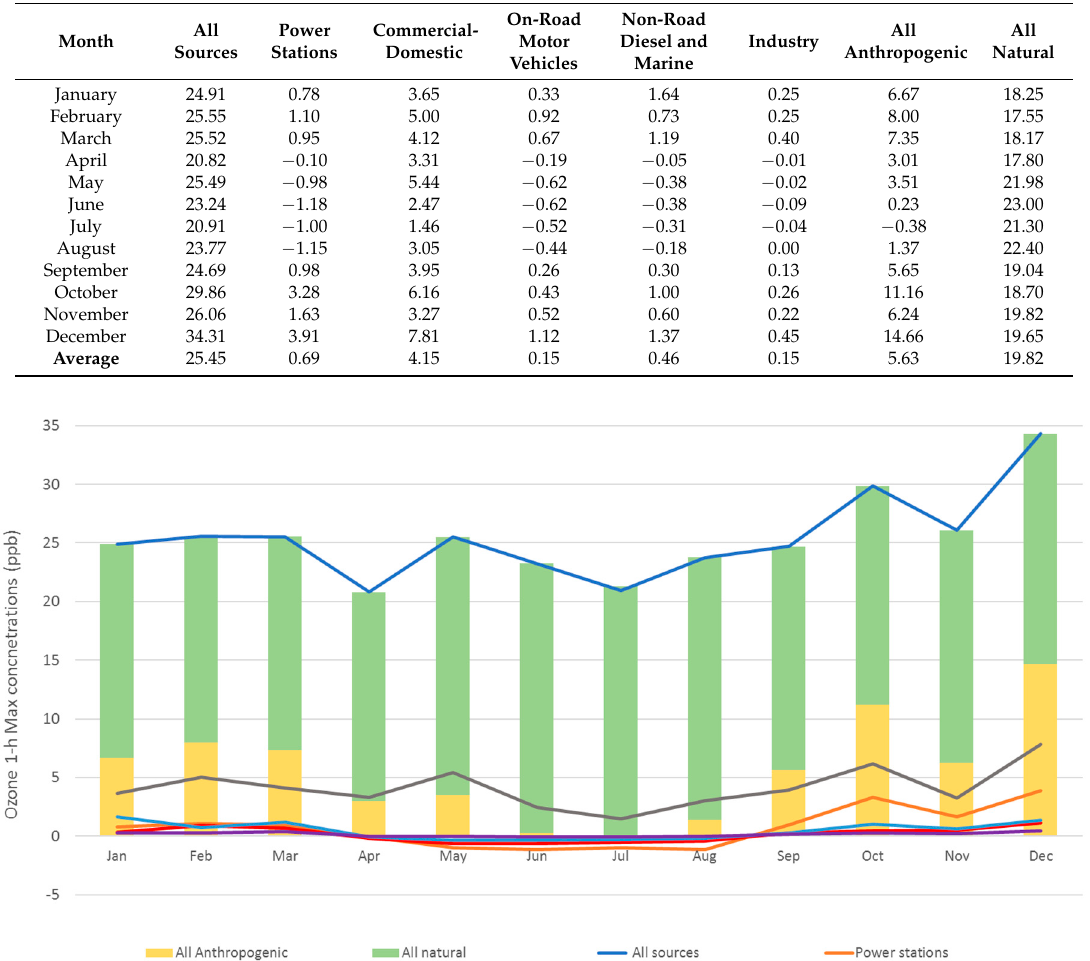
Table A5. Monthly average of daily maximum 1-h predicted ozone concentration (ppb) in the Newcastle region for different months in 2008 under various emission scenarios.